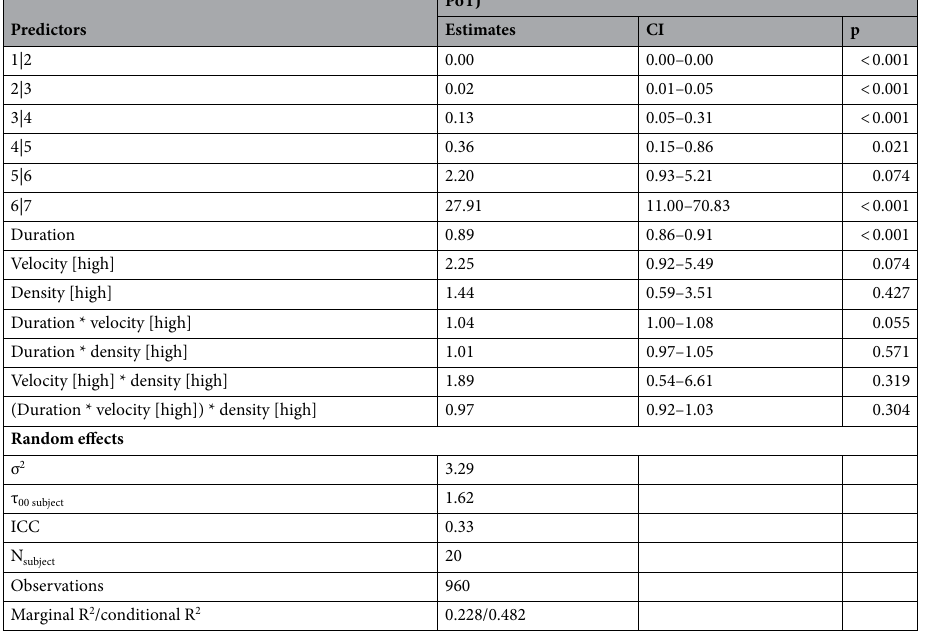
Table 2. Summary of the mixed effects model for PoTJs, including predictors (as fixed effects) for duration, velocity, density, and all potential interactions. Estimates (in s) and their confidence intervals as well as p-values of the individual predictors can be found in the first part of the table. The intercept refers to a (fictional) condition combination of Duration = 0, Velocity = low, Density = low. The estimates of the other predictors can be interpreted as the expected change in DoTJs in case of a corresponding change in the condition. To account for the repeated measures design, participant wise differences were modeled as random intercept for participants. The second part of the table informs about the random effects (mean variance, ‘σ2’; between subject variance, ‘τ00 subject’, intraclass correlation ICC) as well as some general characteristics of the model (N, Observations, R 2